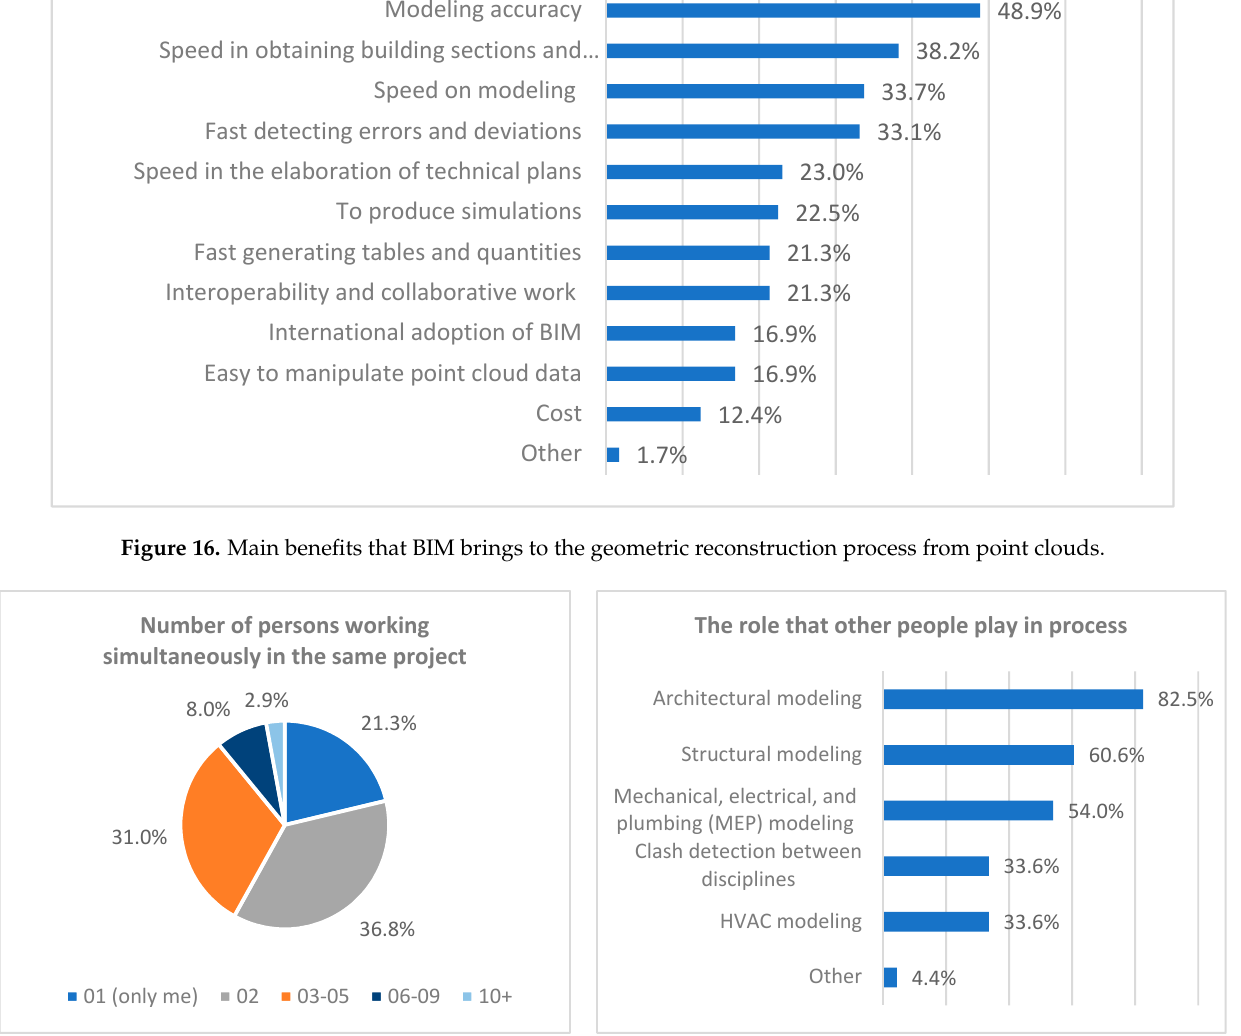
Figure 16. Main benefits that BIM brings to the geometric reconstruction process from point clouds.